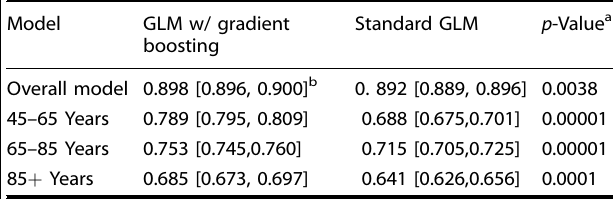
Table 2. The mean area under the operating characteristics curve (AUC-ROC) by